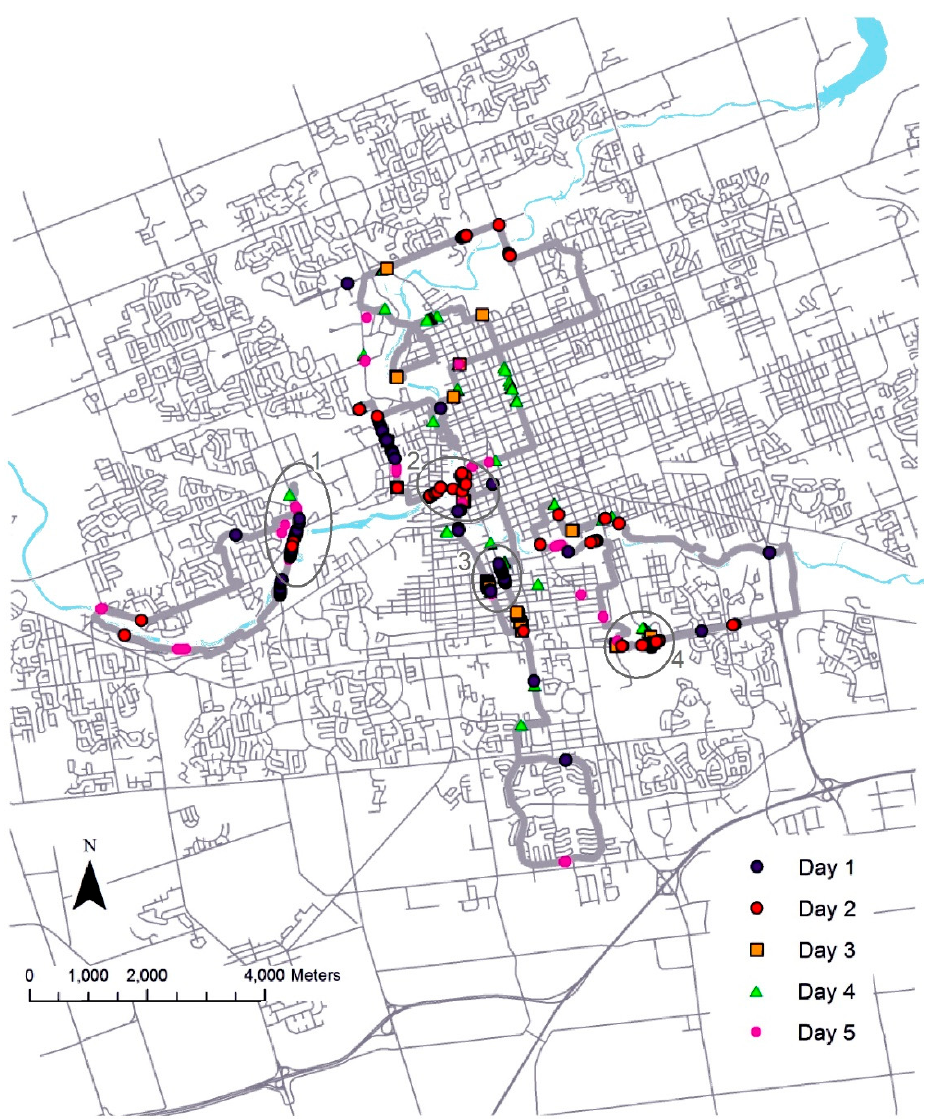
Figure 6. Map of London, Ontario with the top 1% of all recorded values for each of the 5 study days. Clustering is apparent in three regions: approaching the bridge in the west part of the city (1); the downtown urban core (2); and two spots which were noted for being under construction during the course of the study (3, 4).